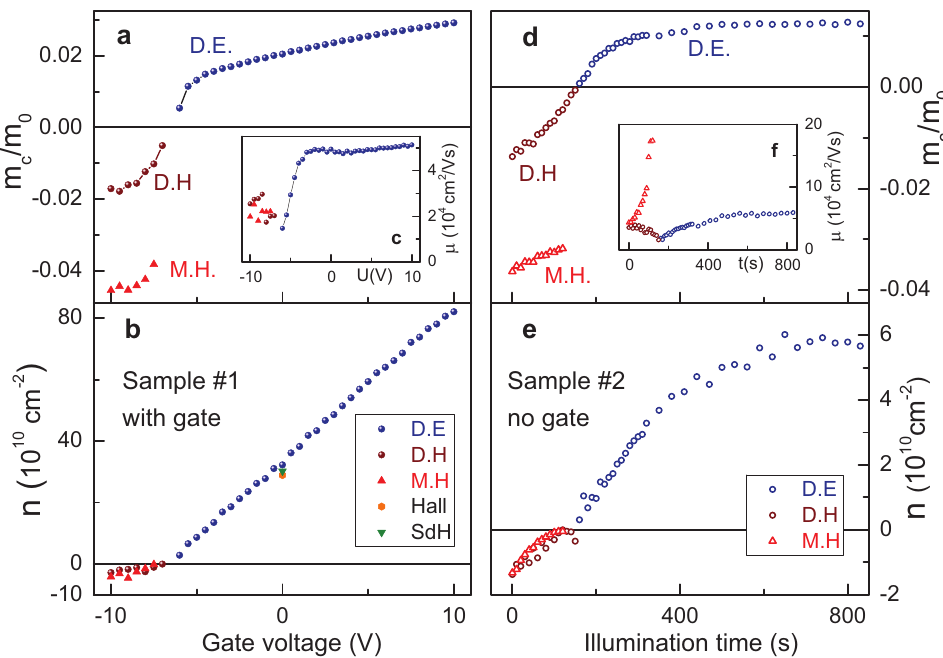
Figure 2. Parameters of the charge carriers as extracted from the Drude fits of the cyclotron